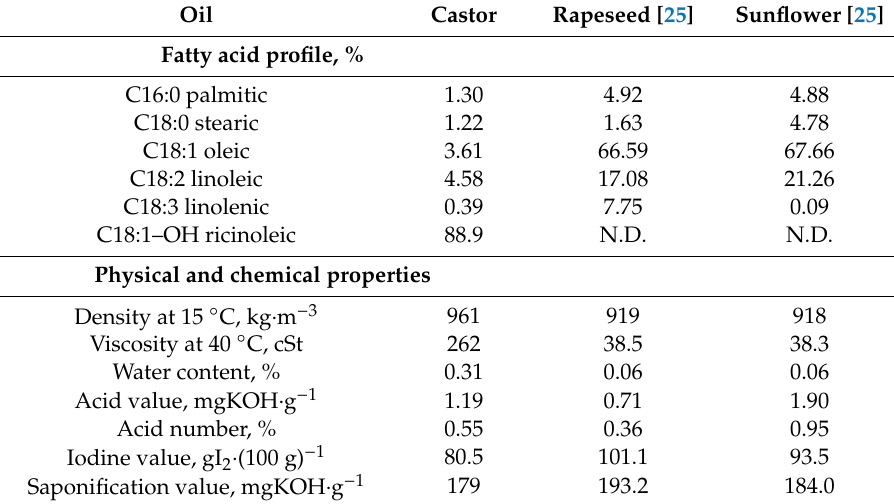
Table 1. Castor oil fatty acid profile and properties and comparison with other biodiesel from vegetable oils. Oil Castor Rapeseed